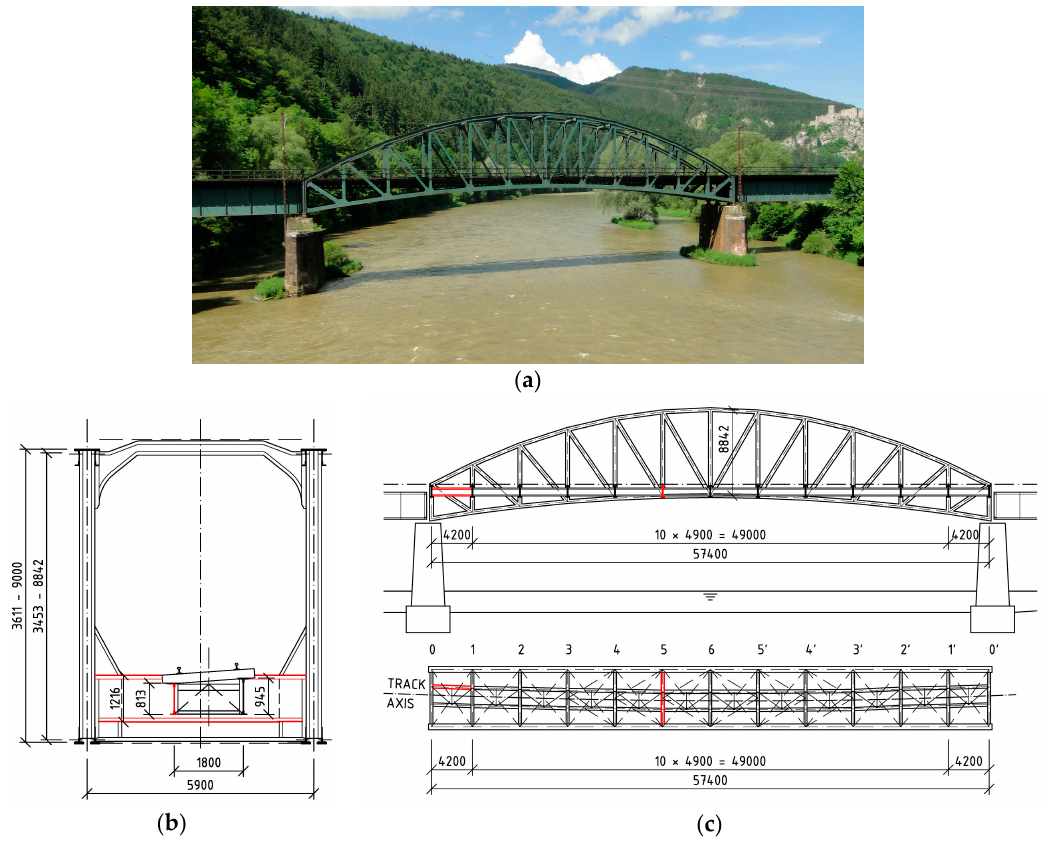
Figure 3. Bridge 3: the 76-year-old superstructure with the middle span built as the truss girder bridge with an intermediate open member deck: ( a ) picture from the side; ( b ) the cross-section; ( c ) schematic side view and ground plan of the superstructure; the chosen elements are drawn in red in ( b ) and ( c ).